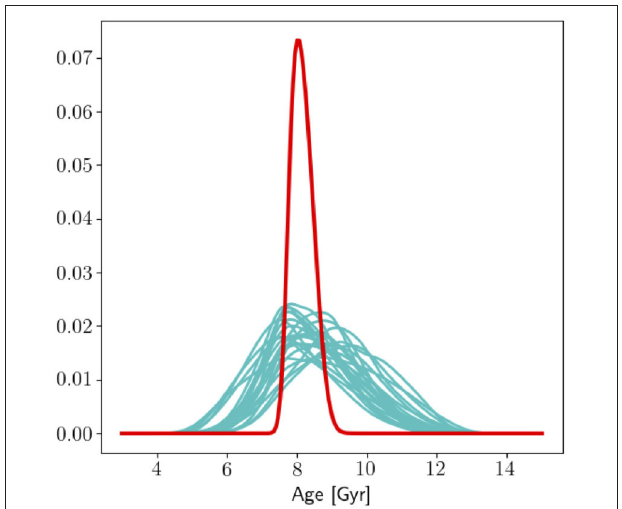
FIGURE 10 | The cyan curves mark the individual probability density functions for age for a sample of red giants in NGC 6791. The red curve is the joint probability assuming that all stars in a cluster have the same age. Note the precision to which the age of the cluster can be determined. Image courtesy of Jean